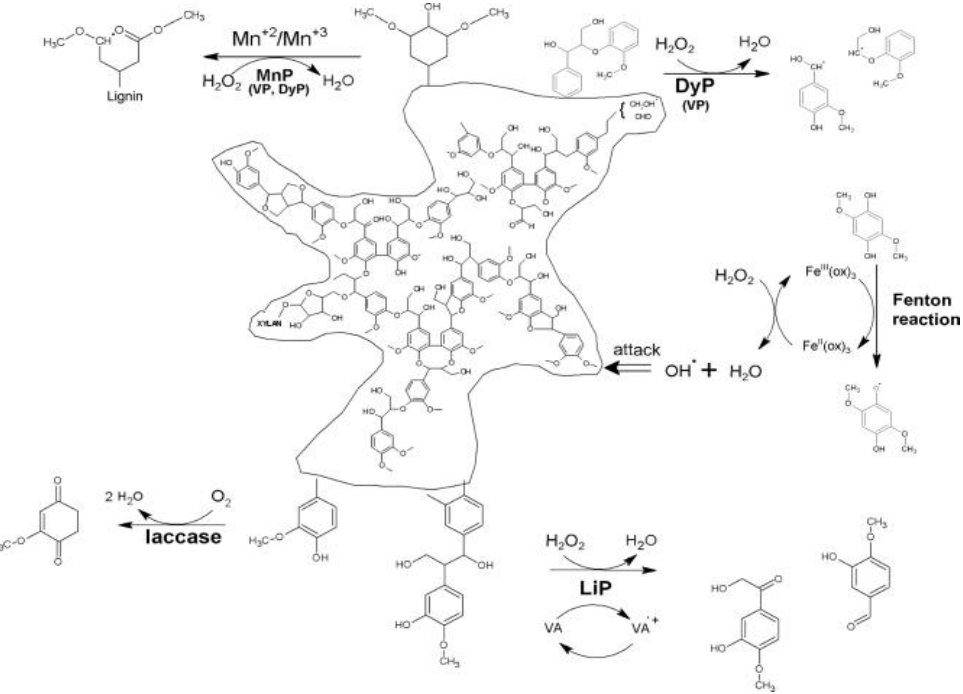
Figure 3. Comparison of lignin degradation by peroxidases and laccase. MnP — manganese peroxi- dase, VP — versatile peroxidase, LiP — lignin peroxidase, DyP — dye-decolorizing peroxidase, ox — oxidase, VP—versatile peroxidase, LiP—lignin peroxidase, DyP—dye-decolorizing peroxidase, oxalate, VA — veratryl alcohol. ox—oxalate, VA—veratryl